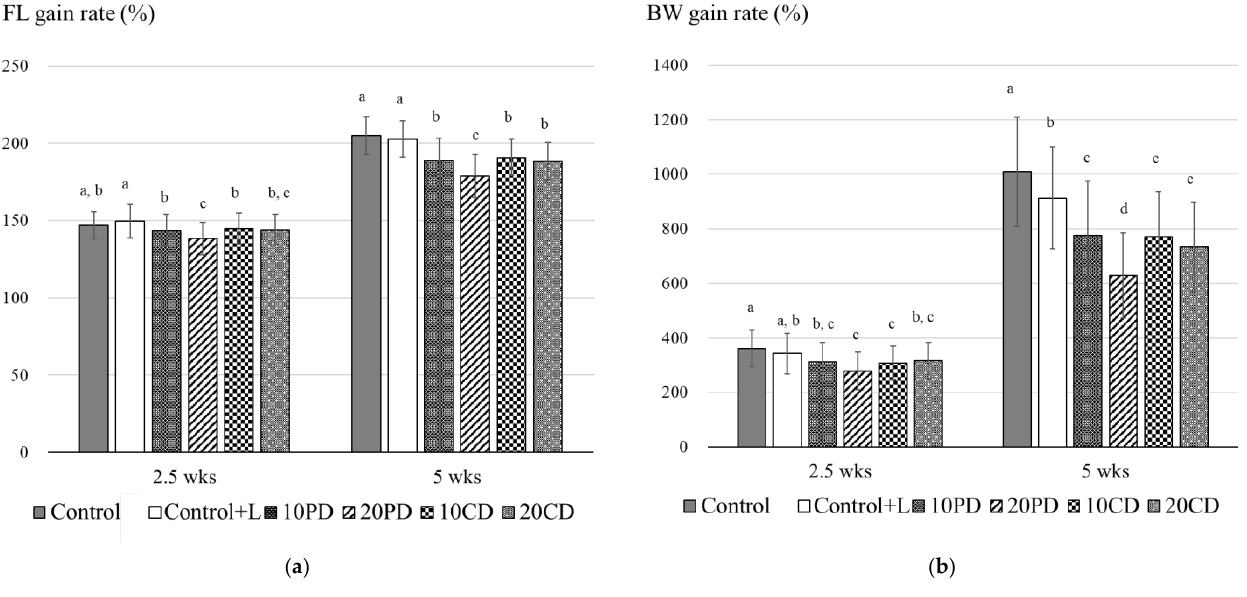
Figure 3. Fork length gain rate ( a ) and body weight gain rate ( b ) of yellowtail in feeding trial 2. Bars indicated S.D. Different letters indicate statistically significant differences according to Kruskal – Wallis test and Mann – Whitney test with Holm’s correction for post hoc comparison ( p < 0.05). Abbreviations: FL, fork length; BW, body weight.